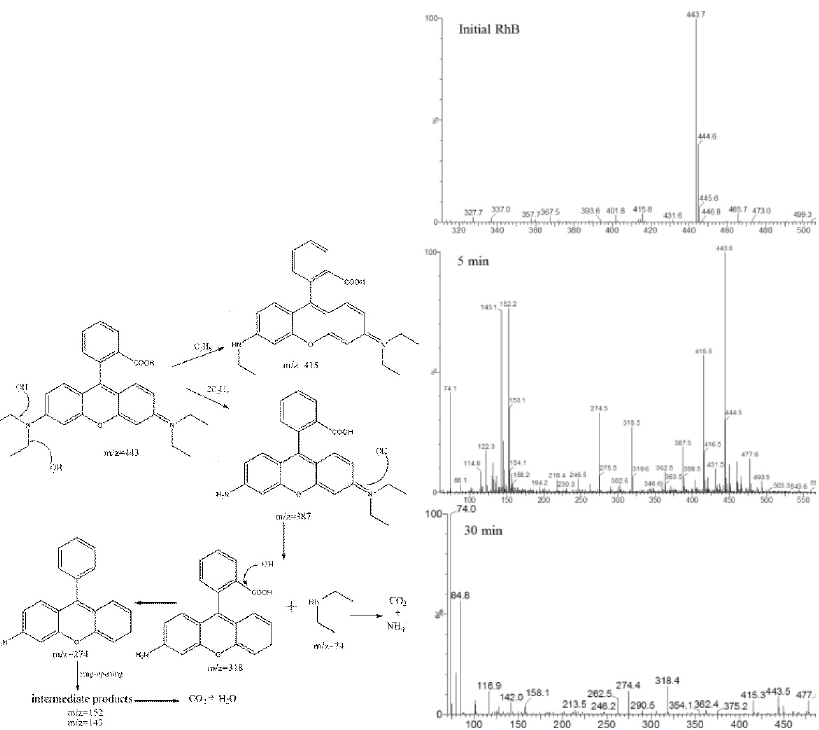
Figure 16. Investigating the mechanism responsible for the degradation of RhB by subjecting an initial RhB solution and solutions containing degradation products formed after 5 and 30 min to mass spectrometry [330].